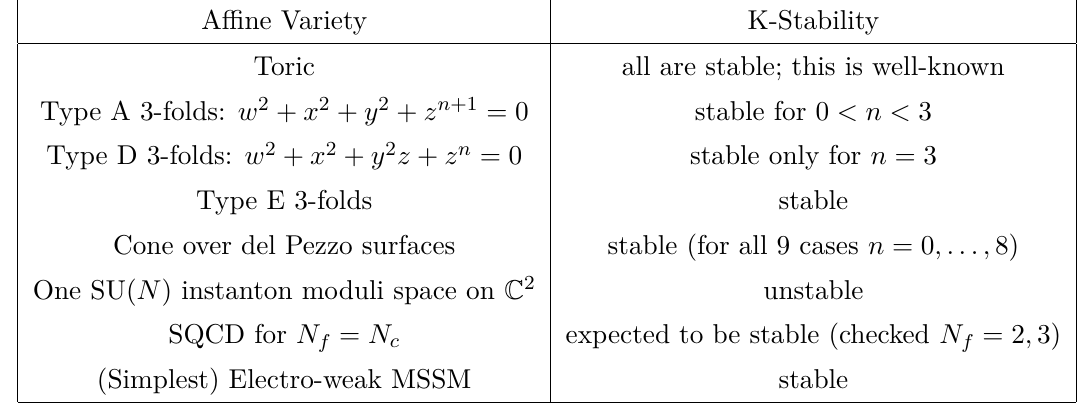
Table 1. K-stability of some of the illustrative examples considered in this paper. The ADE threefolds were also systematically studied in [3,